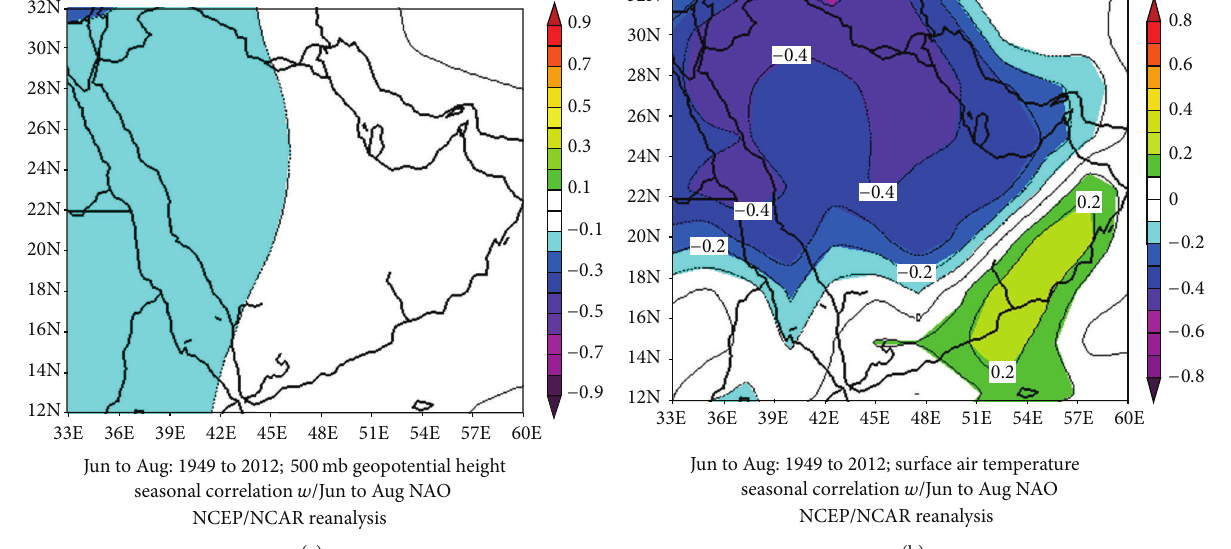
trend through the study period, see Figure 8(a). Surface